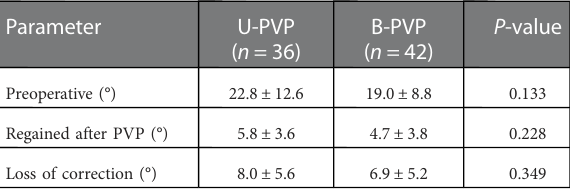
TABLE 3 Preoperative and postoperative sagittal segmental cobb (S-Cobb) angle and loss of correction during the follow-up.